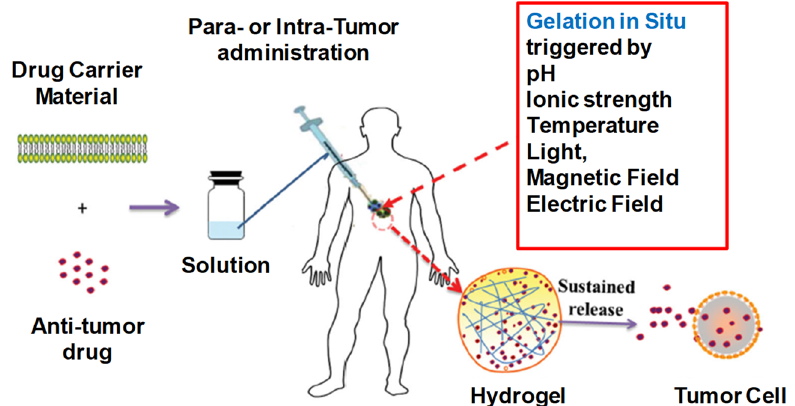
Figure 21. Depiction of in situ gel formation process and its sustained release of drugs from the hydrogel into tumor cells. Reprinted with permission from ref. [67]. Copyright © 2020 from Drug delivery , Taylor and Francis.